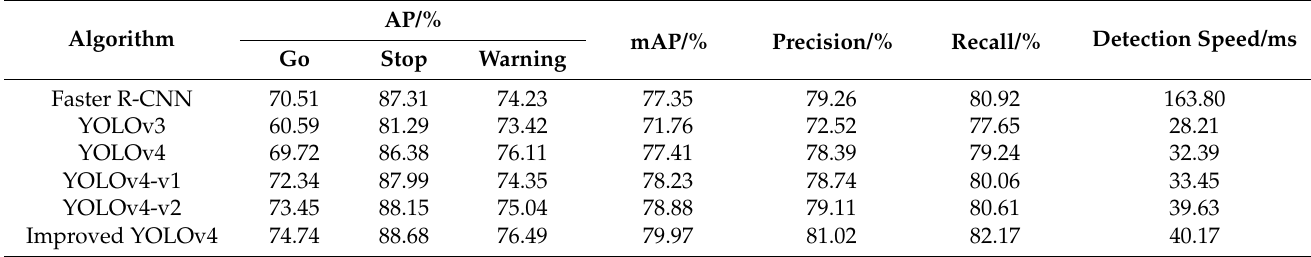
Figure 12. Comparison of recognition results using multiple algorithms for traffic lights in different scenarios in the LaRa data set. ( a ) Faster R-CNN. ( b ) YOLOv3. ( c ) YOLOv4. ( d ) YOLOv4-v1. ( e ) YOLOv4-v2. ( f ) Improved YOLOv4. Table 9. Traffic light recognition performance index in the LaRa data